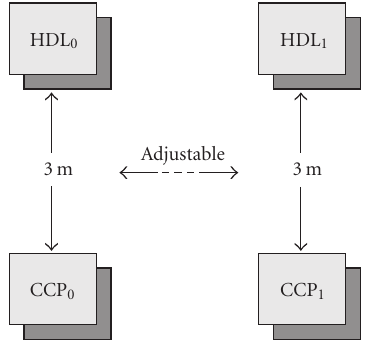
Figure 12: An adjustable configuration of two interfering